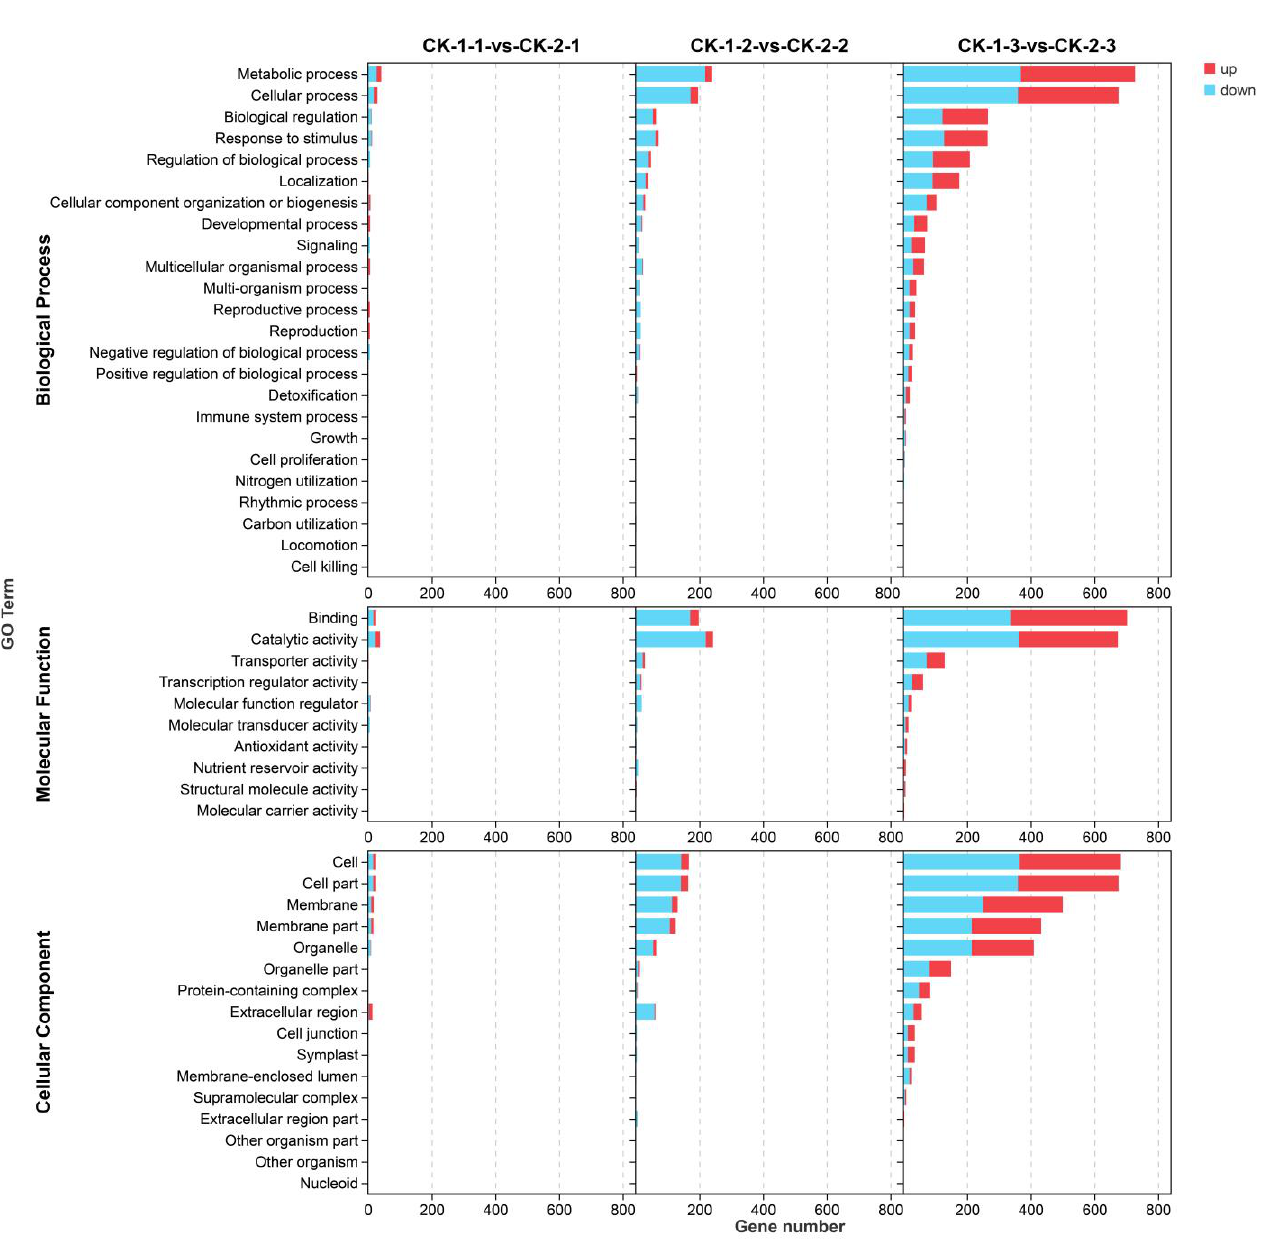
Figure 3. Gene Ontology (GO) functional annotation analysis of DEGs in groups under different stress temperatures.